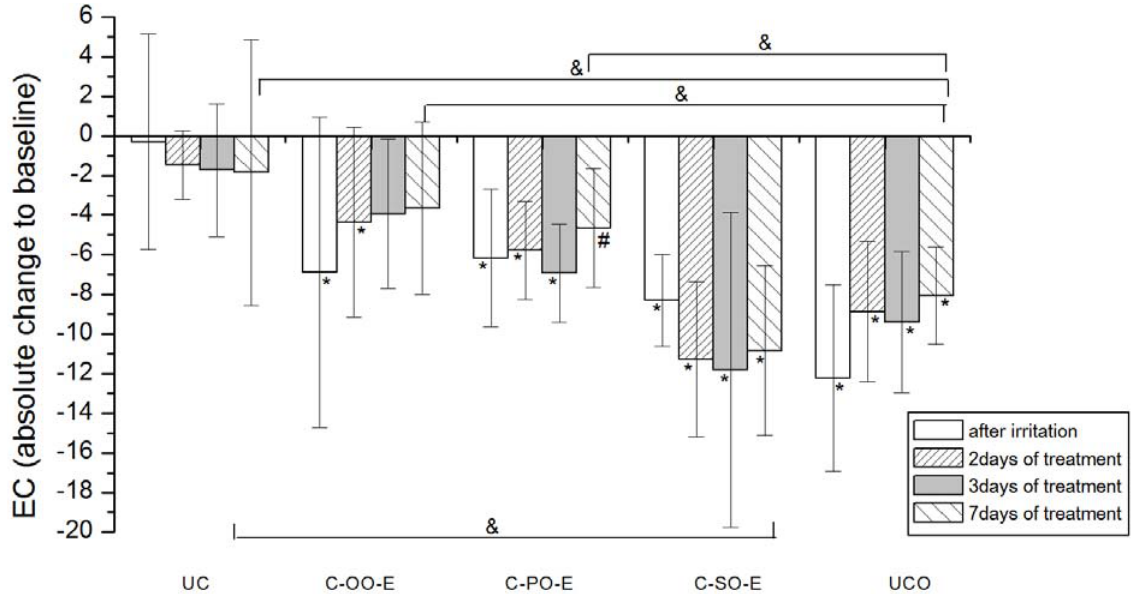
Figure 3. The influence of the irritation per se and samples C-OO-E, C-PO-E and C-SO-E after irritation on EC. Parameters were expressed as absolute changes to baseline at distinct time points. The effects of different formulations were compared mutually and to UC and UCO (significant differences being marked with &). Differences to corresponding sample without SJW (C-OO, C-PO and C-SO) were checked only on day 7, significant differences being marked with (#). (*) is for significant difference of EC at distinct time point related to corresponding baseline (means were